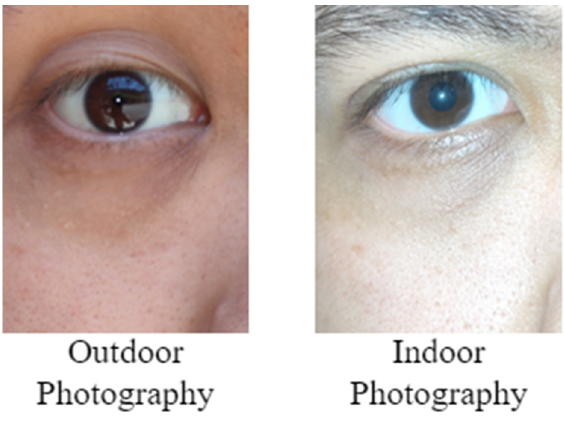
Figure 1. Eye images of Asian people that were captured under different light sources.